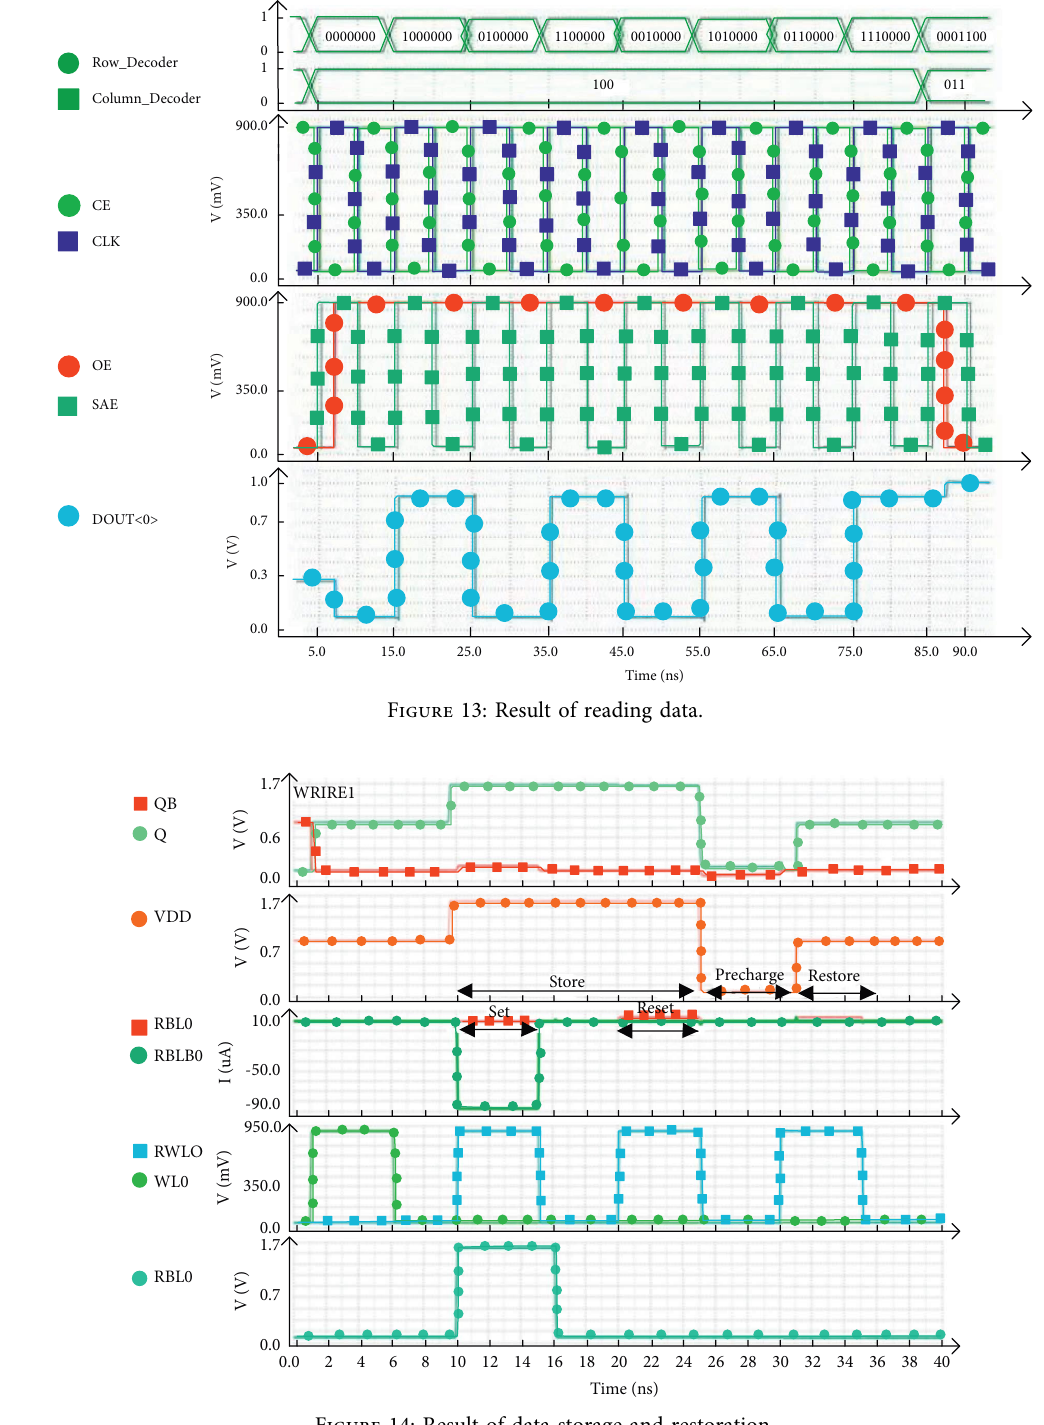
Figure 14: Result of data storage and